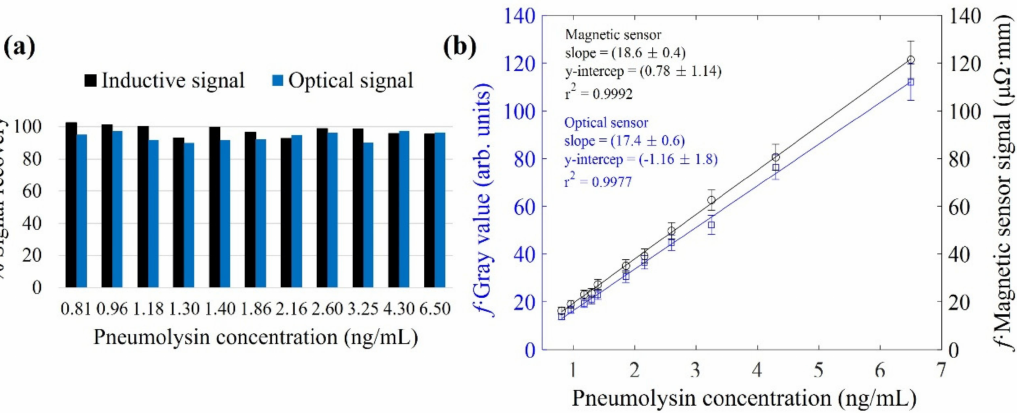
Figure 8. ( a ) Signal recovery percentage for the optical (blue) and inductive (black) sensor. ( b ) Calibration curves obtained for the optical and the inductive sensors with the concentrated values. The error bars are calculated as the sum of the standard deviations of the linear regression of the calibration curve together with the error in the pipetting of each dilution